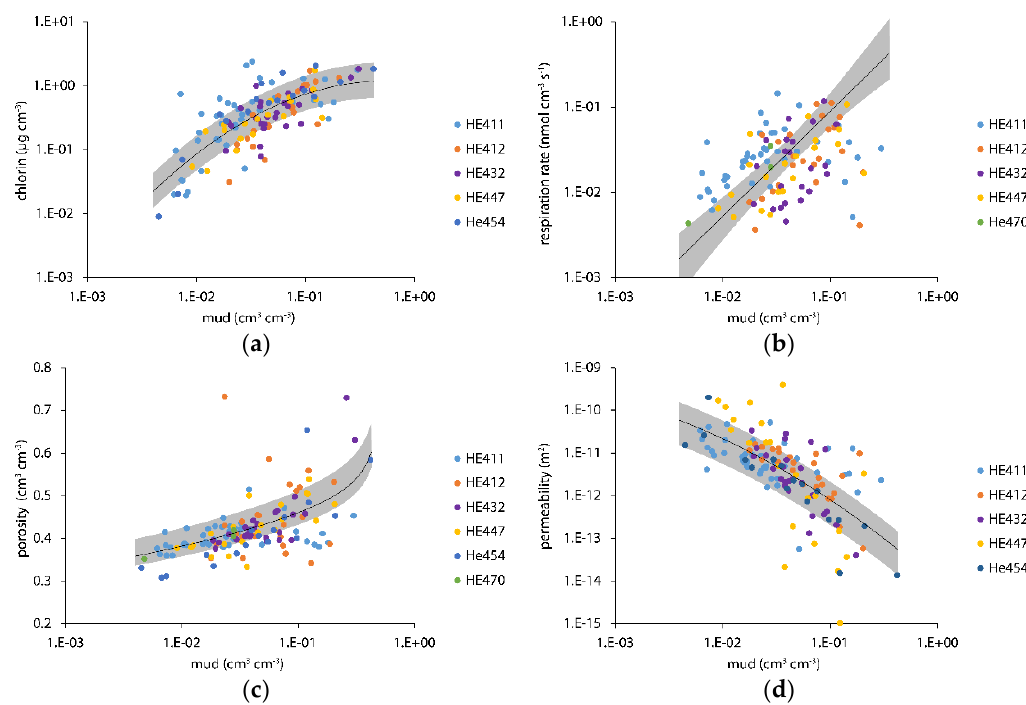
Figure 5. Correlation of the fine mineral particles ( < 63 µ m, mud) content with the ( a ) chlorin content, ( b ) specific respiration rate, ( c ) porosity, and ( d ) permeability. The solid lines indicate he -fit regression, grey bands indicate confidence intervals, and colours indicate the individual sampling cruises.